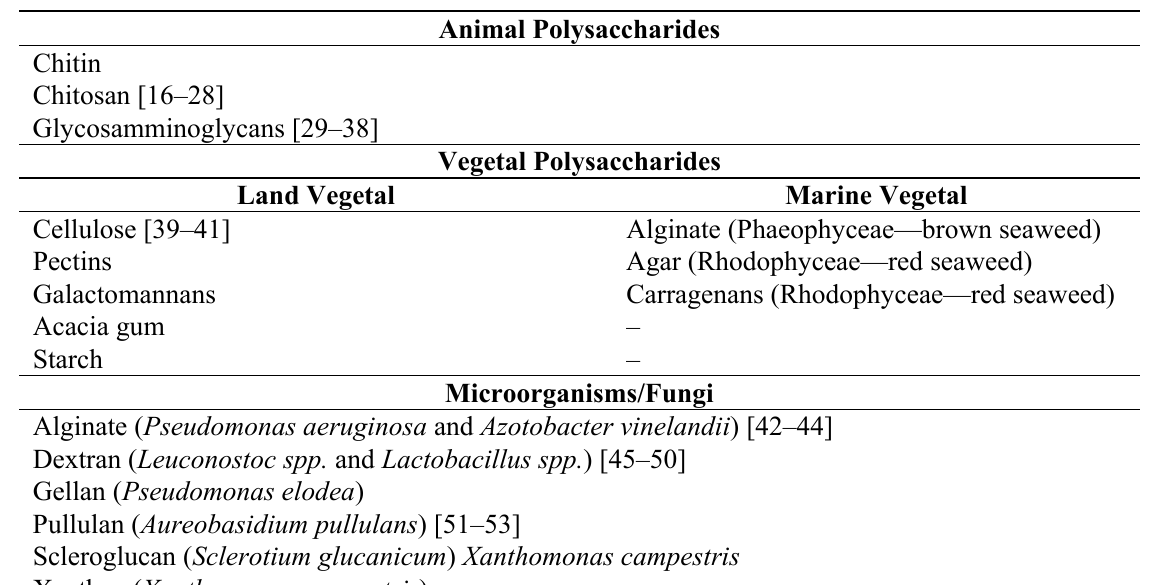
Table 1. Origin of